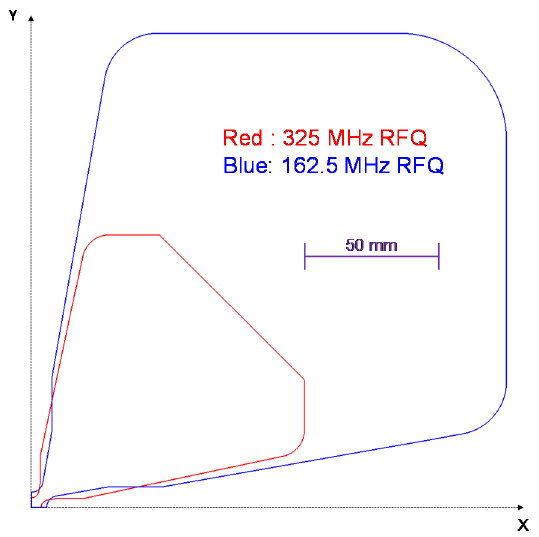
Figure 6. Simulated cross-section profiles in both RFQs: the square shape in blue represents the 162.5 MHz RFQ design, while the octagonal shape in red shows the 325 MHz RFQ design; X and Y are in the units of mm, and the transverse dimension of 325 MHz RFQ is about 60% of that of the 162.5 MHz RFQ.